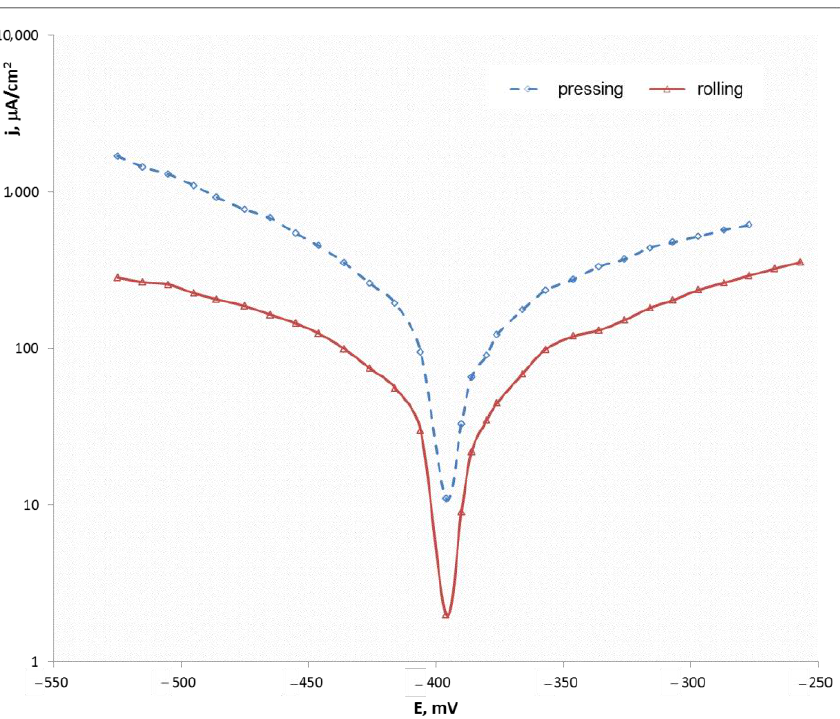
Figure 6. The curves’ potentiostatic polarization for composite coatings with volume fraction ceramic dispersed phase V cdp = 15%Al 2 O 3 after plastic working for pressing and rolling.